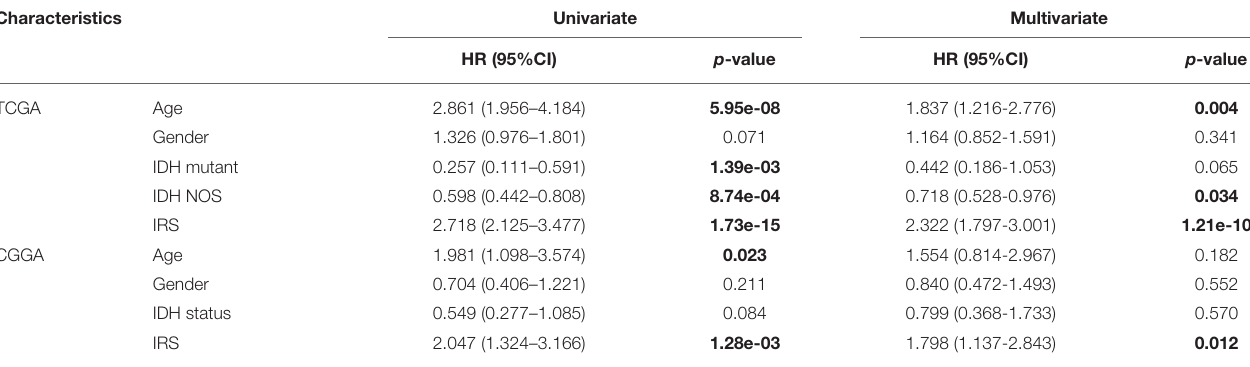
TABLE 2 | Univariate and multivariate Cox regression analysis in training and validation cohorts. Characteristics